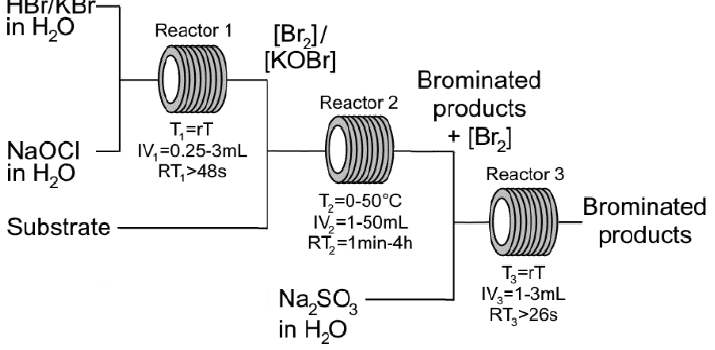
Figure 1. A general scheme for the bromination of organic compounds in flow. The exact parameters used per substrate can be found in Table 1 and Section 3 Materials and Methods.